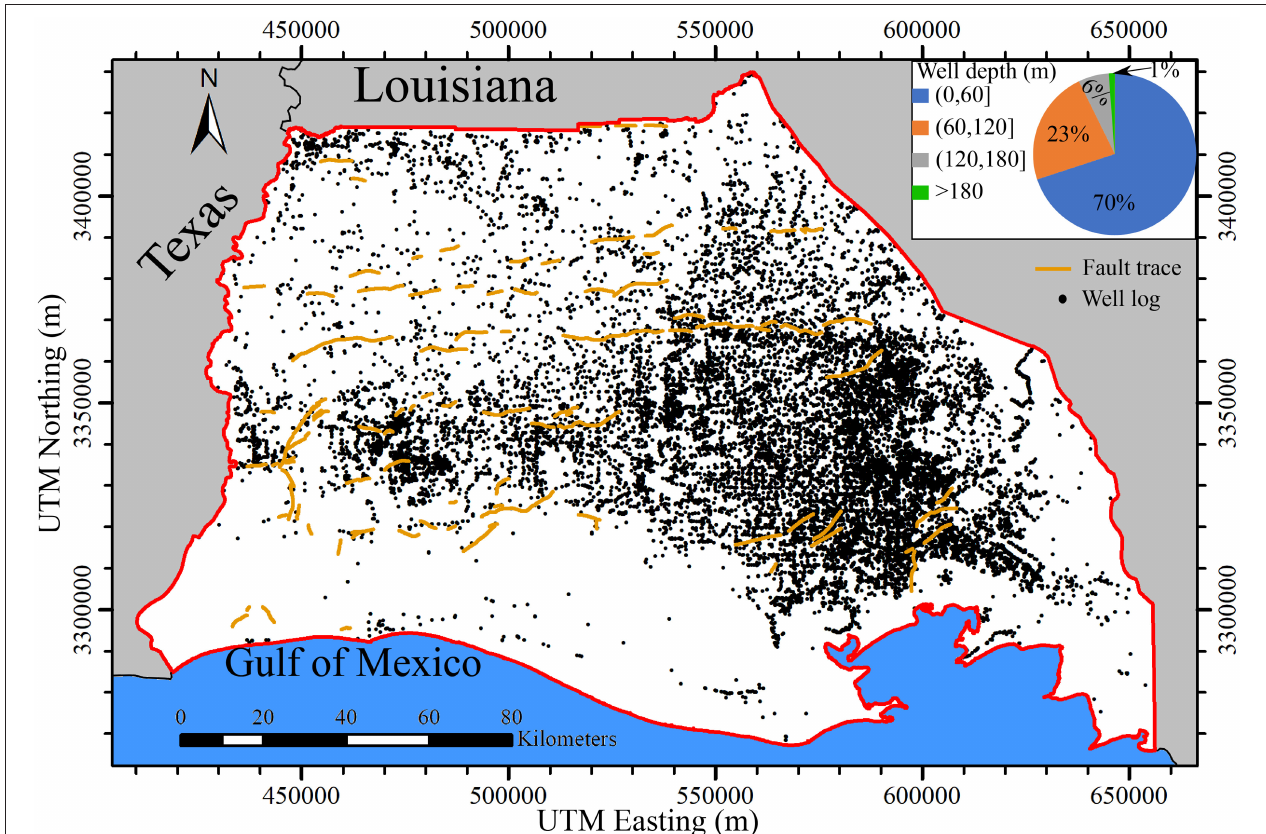
FIGURE 2 | Location of well logs and fault traces in the study area. The pie chart shows the fractions for depth ranges of well logs.